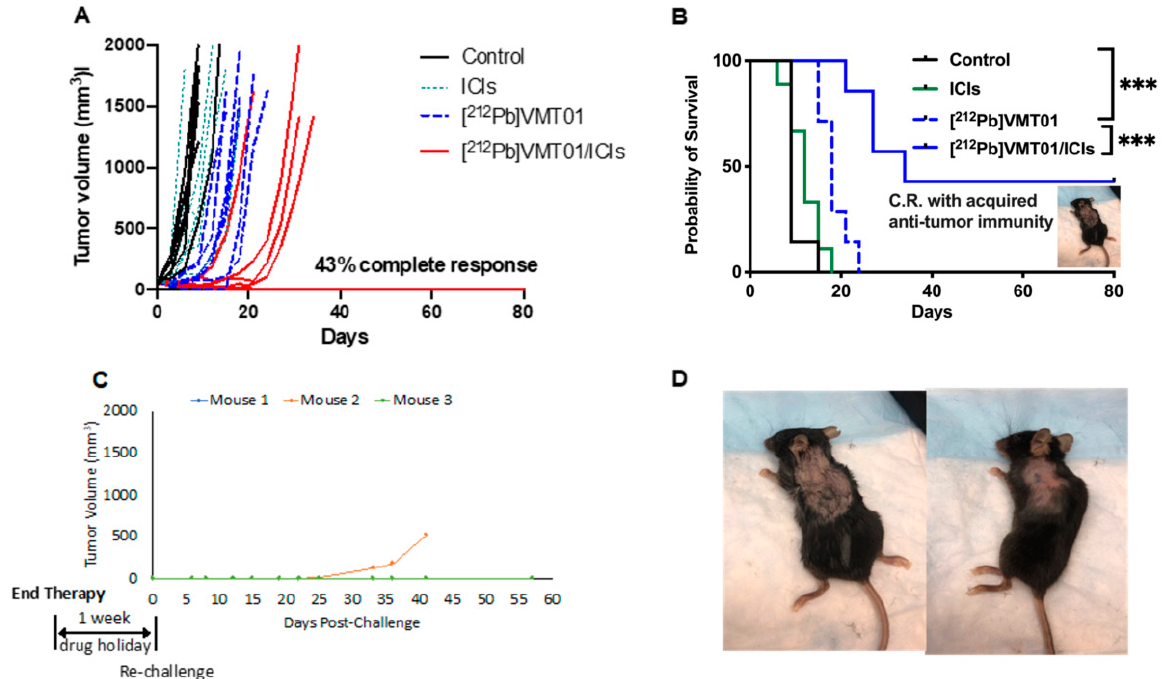
Figure 2. Anti-tumor effect from combination of single dose [ 212 Pb]VMT01 α -TRT and ICIs B16-F10 melanoma. ( A ) Individ- ual tumor volume in animals after treatments of rat IgG isotype control (control), single dose of 4.1 MBq [ 212 Pb]VMT01; 200 µ g of anti CTLA-4 + 200 µ g anti PD-1 (ICIs), and combination of [ 212 Pb]VMT01 and ICIs ( n = 7 in each group); ( B ) Overall fractional survival in C57BL6 mice bearing B16-F10 melanoma that received rat IgG isotype control, [ 212 Pb]VMT01, ICIs, and combination of [ 212 Pb]VMT01 and ICIs ( n = 7 in each group); Statistic analysis was performed using Gehan-Breslow- Wilcoxon test: *** p < 0.001; ( C ) Individual tumor growth of B16-F10 tumor re-challenge in mice with complete response to combination of [ 212 Pb]VMT01 and ICIs; ( D ) Mice rejected further implantation of B16-F10 melanoma tumor up to 60 days after re ‐ challenge.